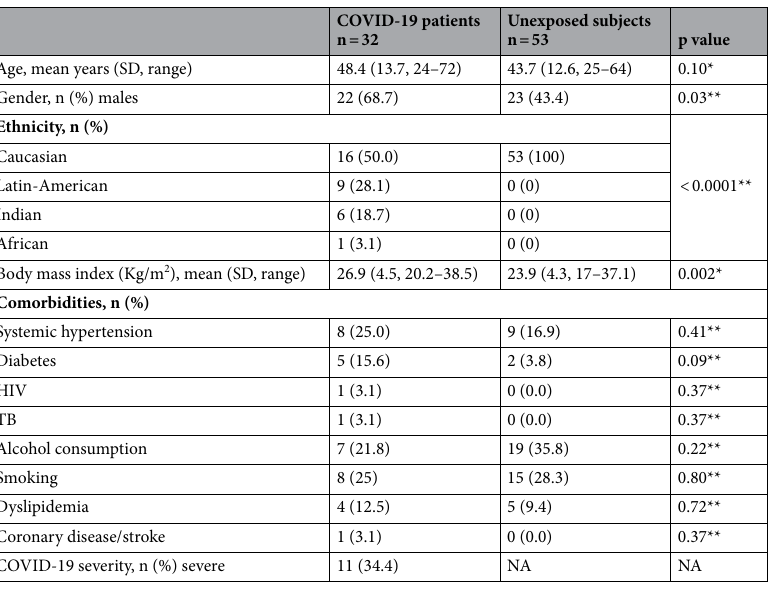
Table 1. Demographics and clinical features of subjects enrolled in the study. COVID-19 coronavirus disease 19, n number, SD standard deviation, NA not available, HIV human immunodeficiency virus, TB tuberculosis. *t-test. **Fisher’s exact